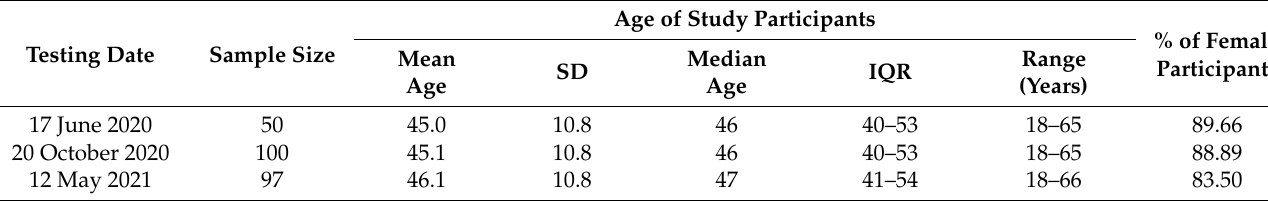
Table 1. The characteristics of the study